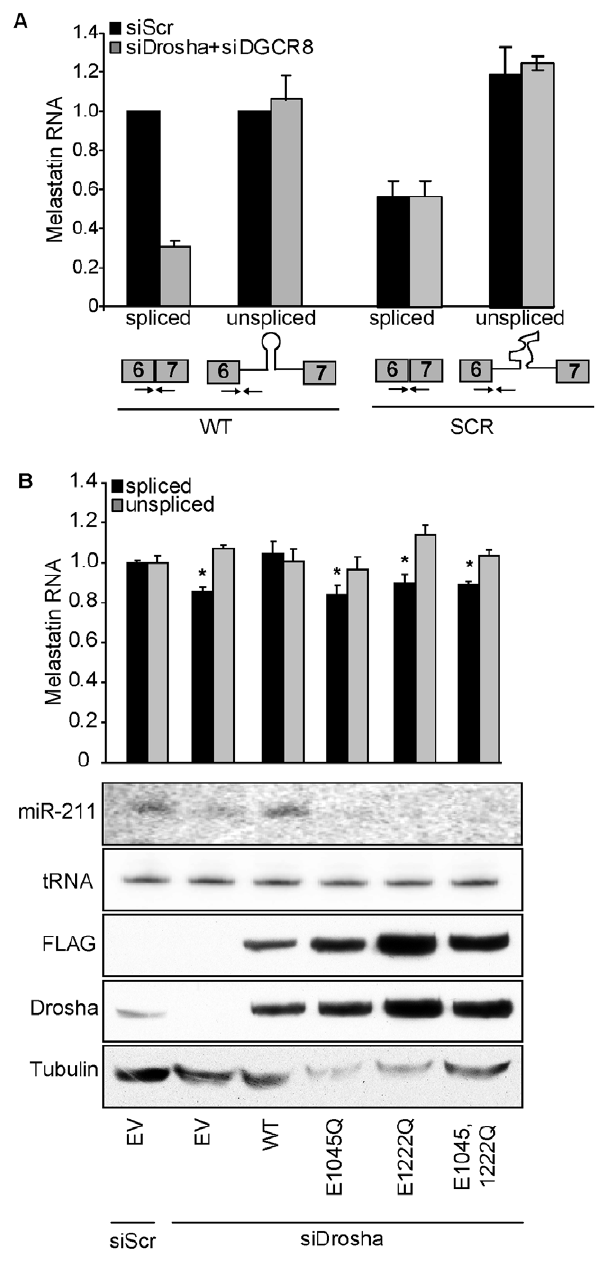
Figure 2. The RNase III activity of Drosha is required to promote splicing at a miR-211–hosting intron. (A) Eliminating the miR-211 hairpin from intron 6 reduces splicing efficiency of a melastatin mini-gene containing intron 6 flanked by exons 6 and 7. Wild-type (WT) mini-gene or a mini-gene in which the miR-211 hairpin was replaced by a scrambled sequence (SCR) were transfected into HeLa cells, and the levels of fully-spliced and unspliced transcripts were quantified by qRT- PCR before and after Drosha and DGCR8 knockdowns. (B) RNase III- inactive Drosha does not promote splicing of a miR-211-hosting intron. An empty vector (EV) or vectors containing siRNA-resistant isoforms of either WT or RNase III mutant (E1045Q, E1222Q, and E1045,1222Q) Drosha were co-transfected with WT melastatin mini-gene into HeLa cells treated with Scr or Drosha-specific siRNAs. Proteins (FLAG, Drosha, Tubulin) or RNAs (miR-211 and tRNA) were detected by Western and Northern blotting, respectively. Spliced and unspliced forms of the mini-gene transcript were quantified by qRT-PCR (p , 0.05, Student’s t- Test).